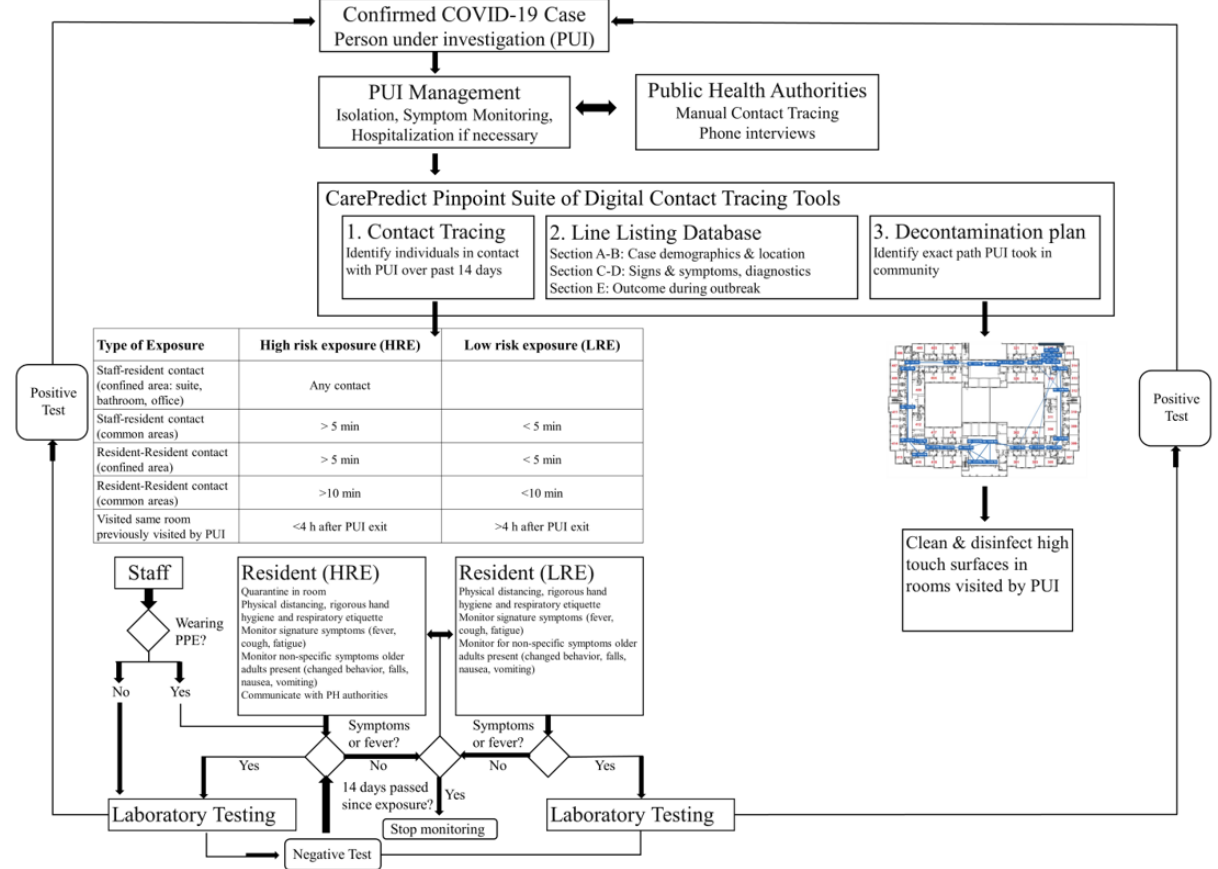
Figure 3. Sample representation for integrating CarePredict’s PinPoint system and software into a long-term care facility's COVID-19 risk assessment workflow. General workflow diagram developed to be consistent with those proposed by the European Centre for Disease Prevention and